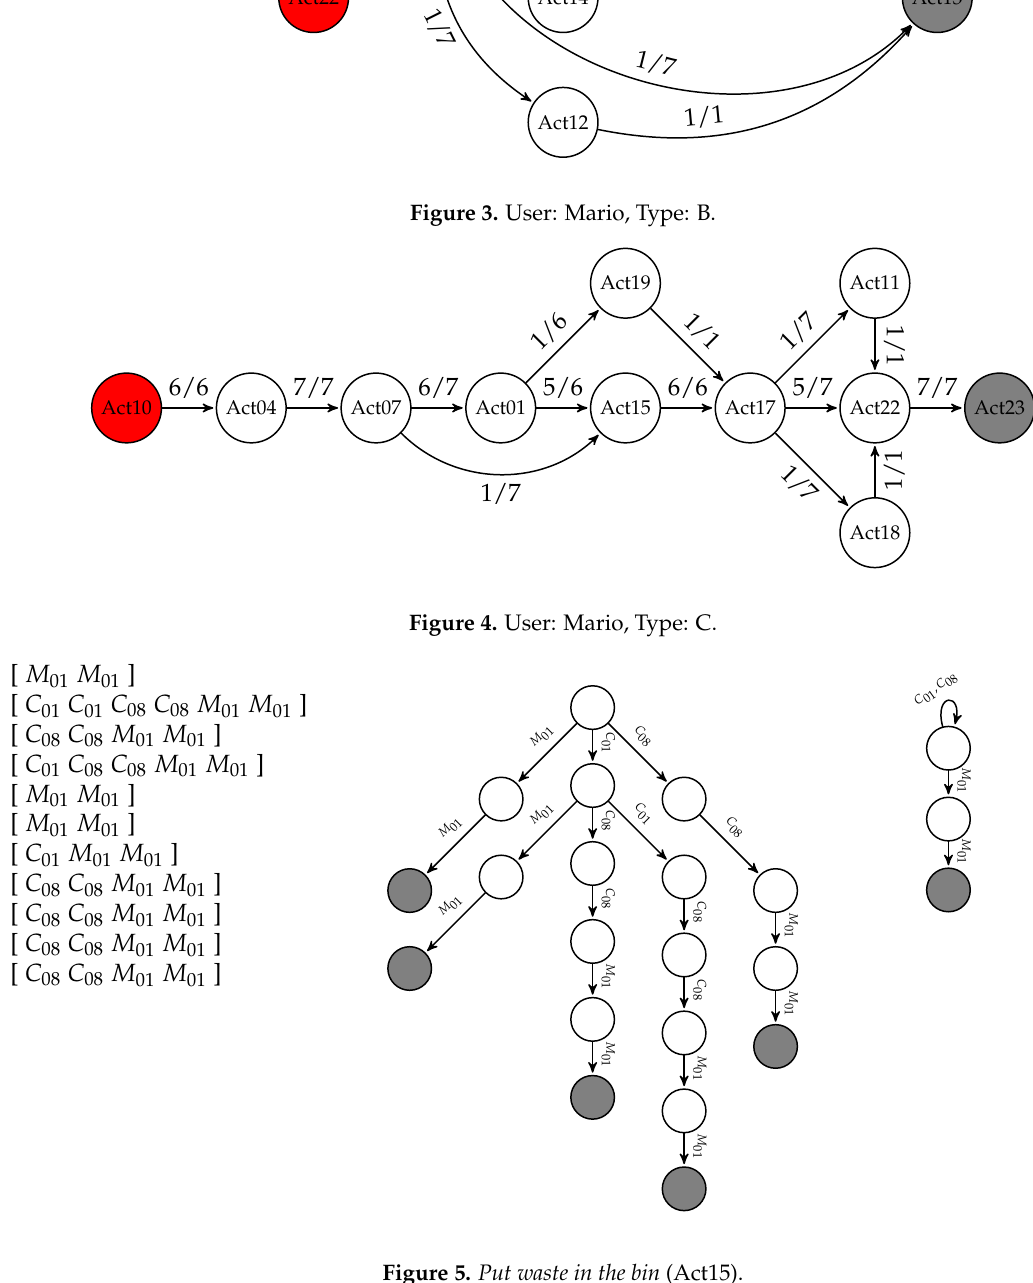
Figure 5. Put waste in the bin